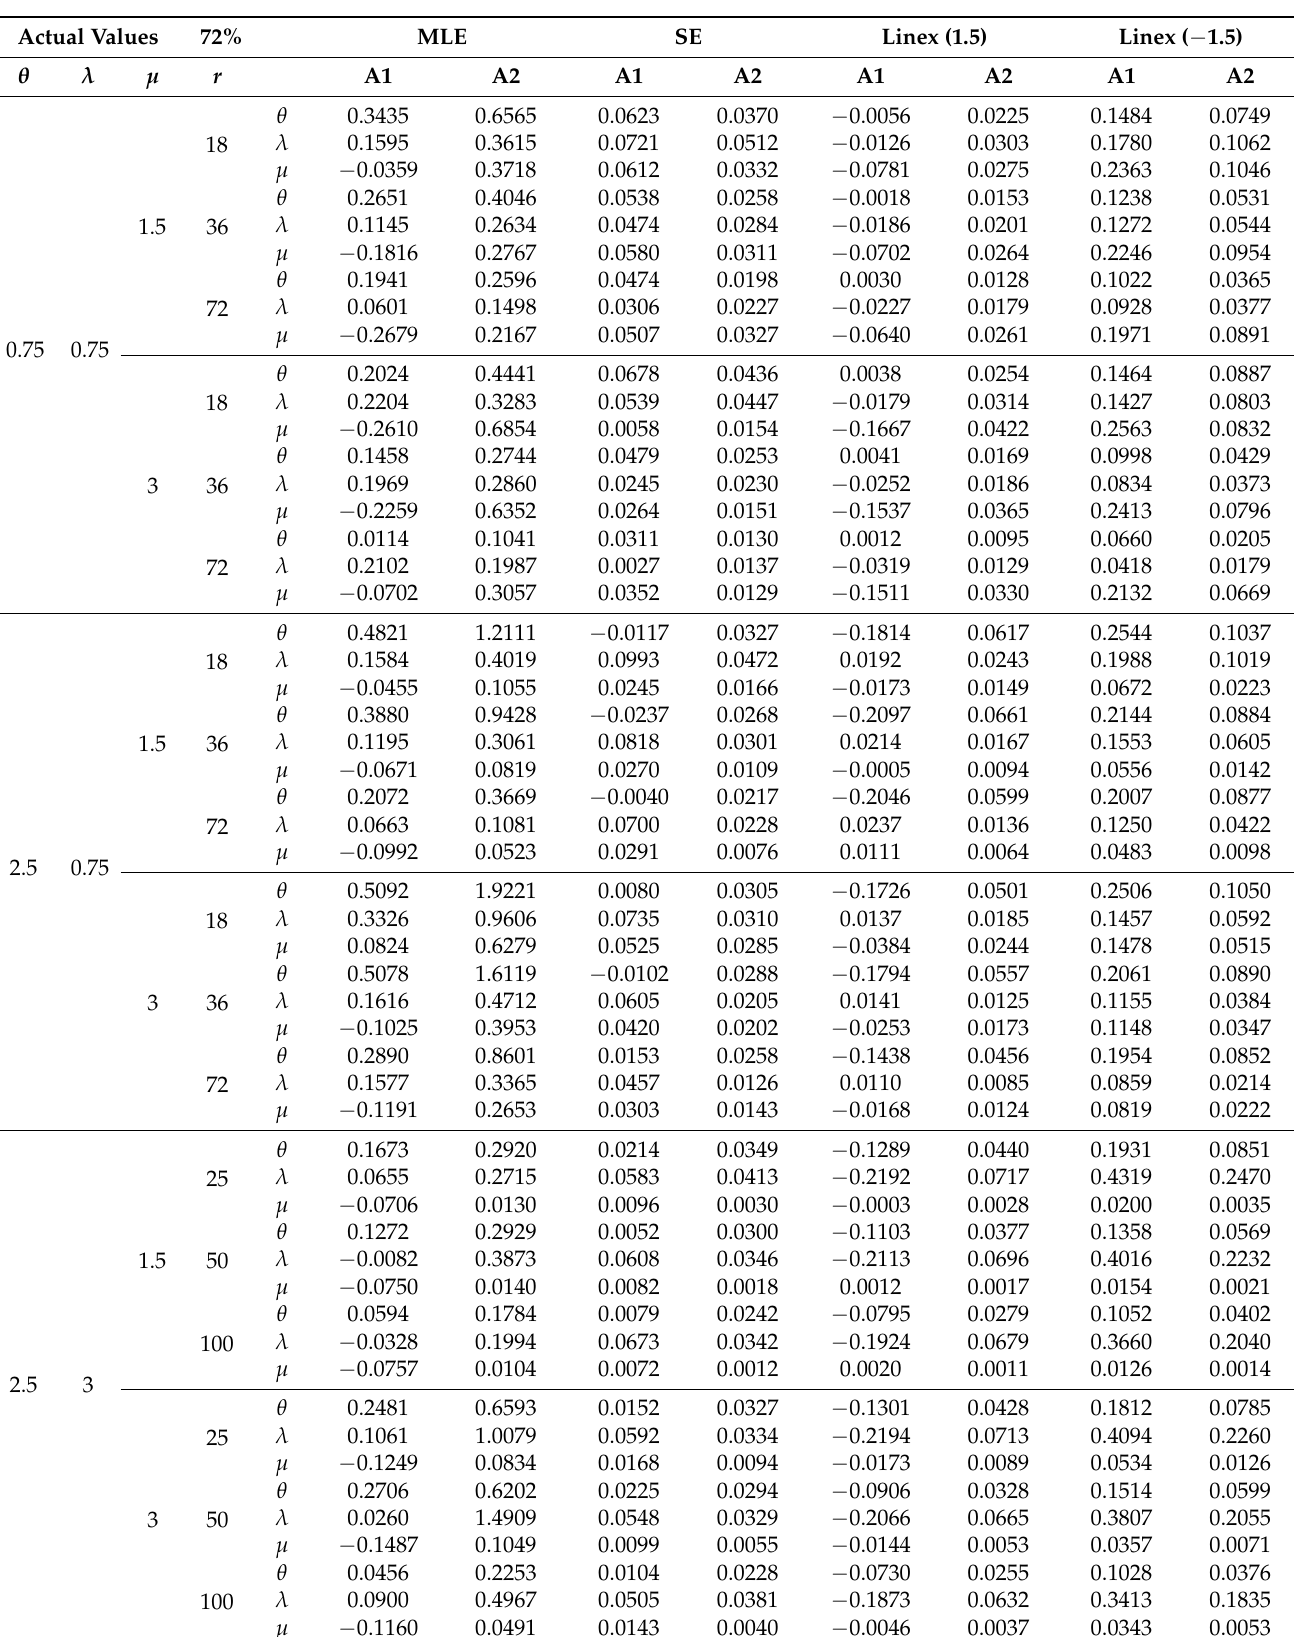
Table 2. MLE and Bayesian estimate for TCPWE model at Type-II censored sample at